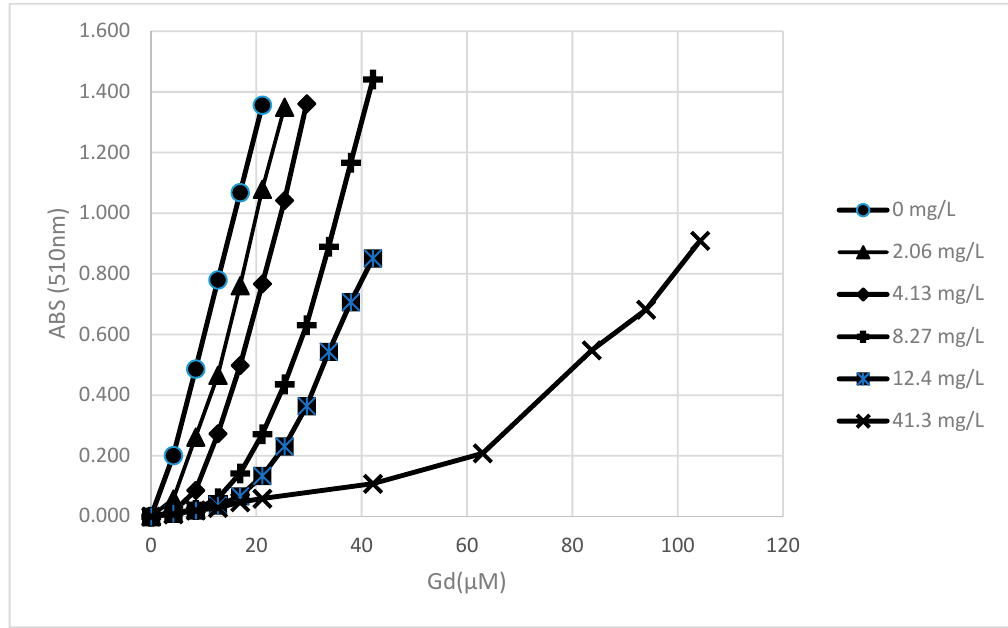
Figure 5. Summary of the Gd 3+ titration data, at pH 8, for the various concentrations of tannic acid that were investigated using this technique.